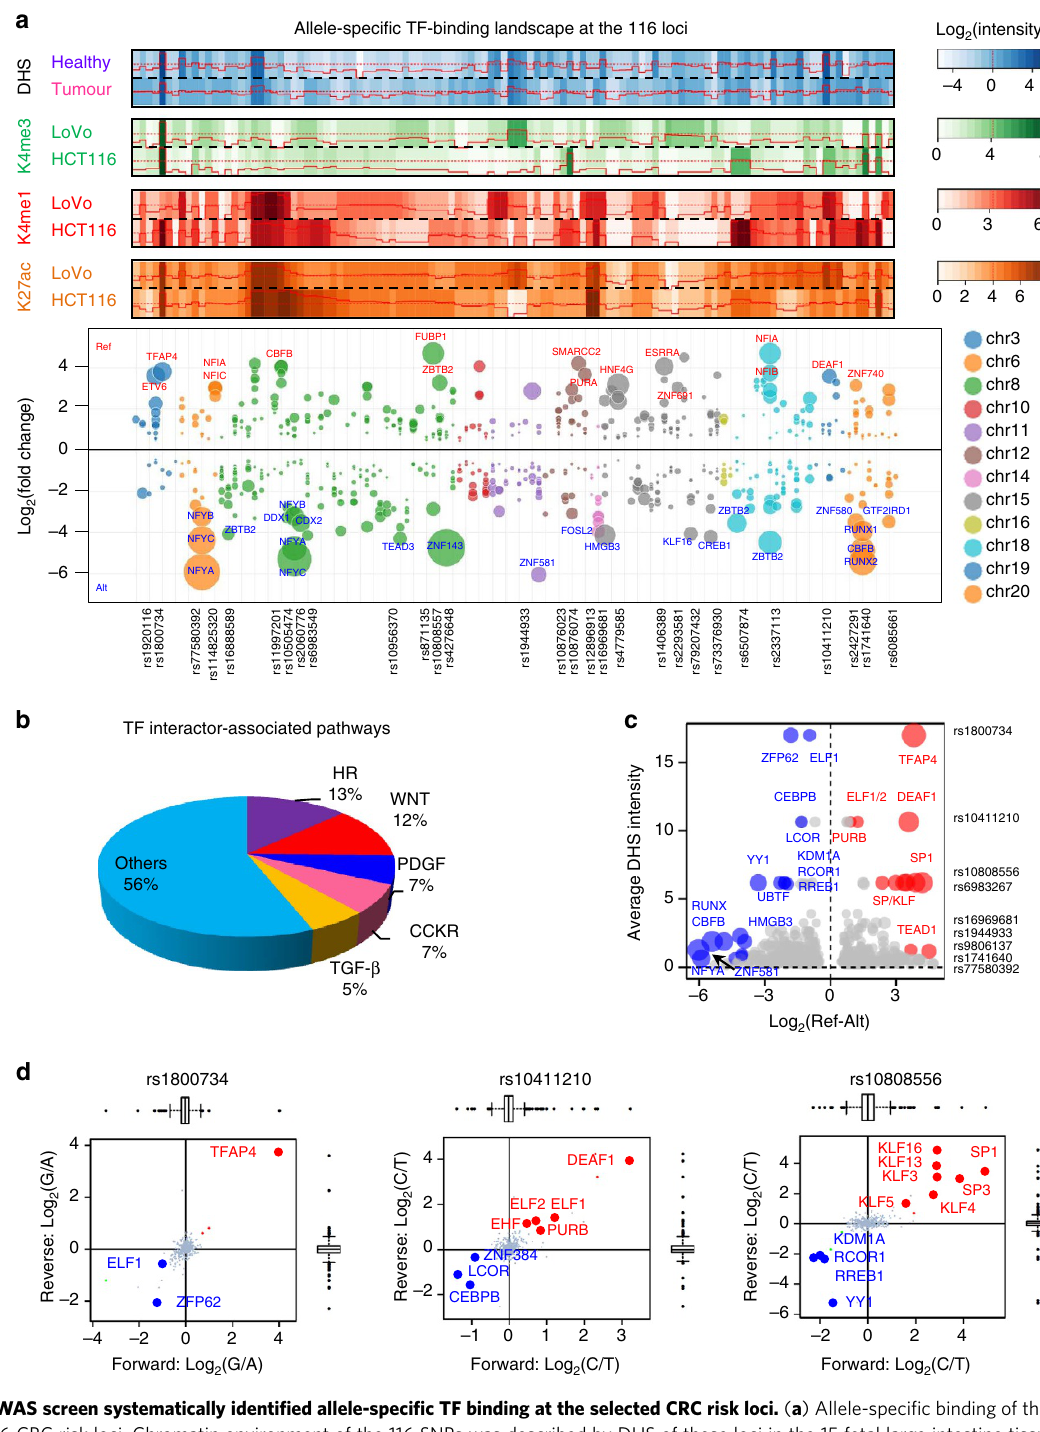
Figure 1 | PWAS screen systematically identified allele-specific TF binding at the selected CRC risk loci. ( a ) Allele-specific binding of the 731 candidate TFs at the 116 CRC risk loci. Chromatin environment of the 116 SNPs was described by DHS of these loci in the 15 fetal large intestine tissues and 12 CRC cell lines, and histone modifications (H3K4me3, H3K4me1 and H3K27ac) within ± 1kb regions around these loci in the LoVo and HCT116 cell lines. The TFs with P -value o 10 (cid:3) 30 and absolute Log 2 (fold change) 4 3 was listed in the bubble plot. Bubble size represents (cid:3) Log 10 ( P -values) of the interactors in the pull-down screen ( n ¼ 2 pulldowns per SNP, P -values: A/B significance test). ( b ) Pathway annotation of the 731 TFs (HR, gonadotropin-releasing hormone receptor pathway; WNT/PDGF/CCKR/transforming growth factor (TGF)- b , Wnt/PDGF/Cholecystokinin/TGF- b signalling pathways). ( c ) TF–SNP interactions ranked by fold changes in the PWAS screen and DHS at the SNP loci. Bubble size indicates the (cid:3) Log 10 ( P -values) of the TF–SNP interactions ( n ¼ 2 pulldowns per SNP, red and blue bubbles: P -value o 0.05, Z -test). ( d ) The top three candidate TF–SNP interactions ( n ¼ 2 pulldowns per SNP, red and blue dots: P -values o 0.01, A/B significance